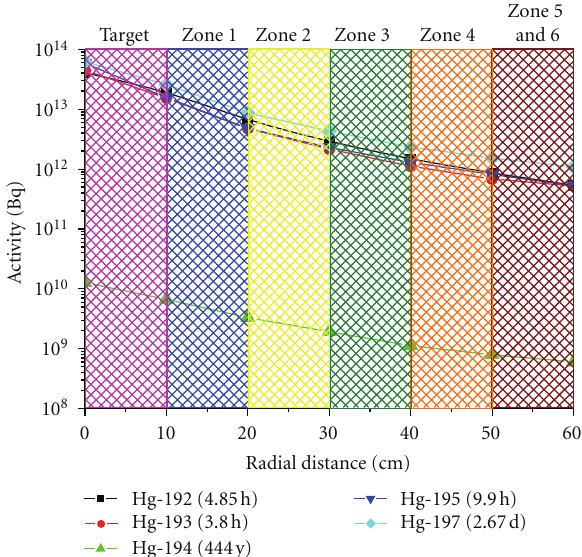
Figure 7: The radial dependence of Hg isotopes activity. Rings 1 to 6 denote the fuel assembly groups corresponding to Figure